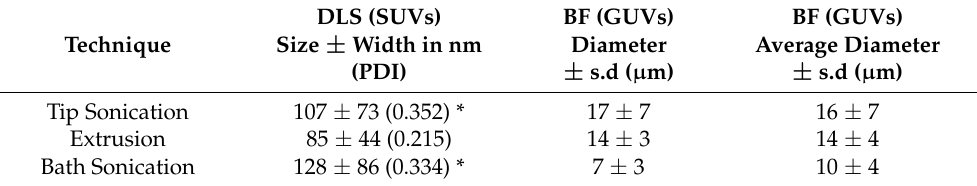
Table 1. Impact of different SUV preparation techniques on their size and their ability to make GUVs. SUV size was characterised by dynamic light scattering (column DLS). The width of the peak is reported as error, and the reported PDI is in parenthesis. * indicates presence of a much smaller second peak corresponding to a larger object size, indicating presence of aggregates. GUVs formed using each of these category of SUVs was characterised in terms of size using bright-field microscopy (column BF). Diameter reports averages from experiments using the same batch of SUVs as DLS (between 10 and 20 GUVs were measured for each case). Average diameter reports averages from 3 different days (at least 10 GUVs each). The standard deviation is reported as error. DLS (SUVs) BF (GUVs) BF (GUVs) Technique Size ± Width in nm Diameter Average Diameter (PDI) ± s.d ( µ m) ± s.d ( µ m) Tip Sonication 107 ± 73 (0.352) * 17 ± 7 16 ± 7 Extrusion 85 ± 44 (0.215) Bath